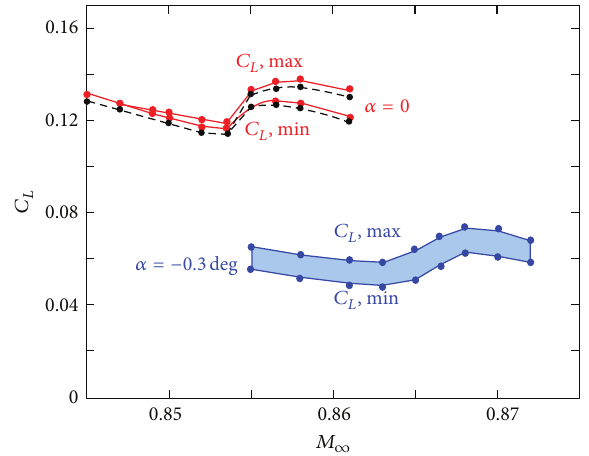
Figure 8: Lift coefficient 𝐶 𝐿 versus 𝑀 ∞ for the swept wing at two angles of